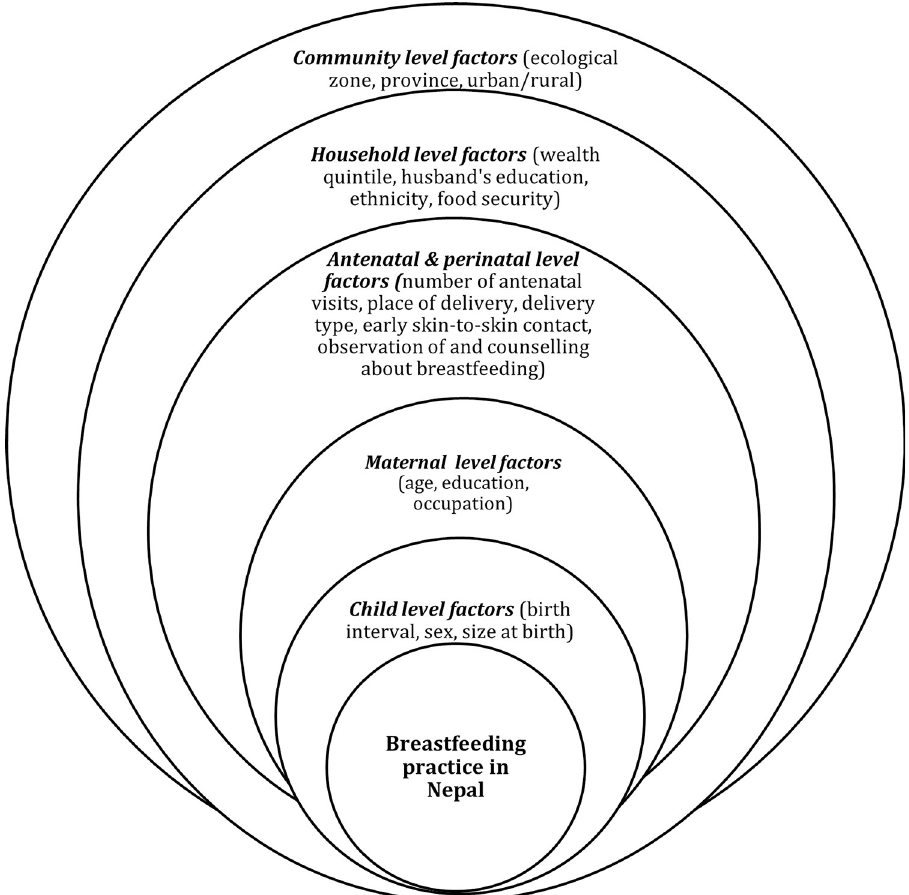
Fig 1. Adapted conceptual framework for breastfeeding outcomes in Nepal